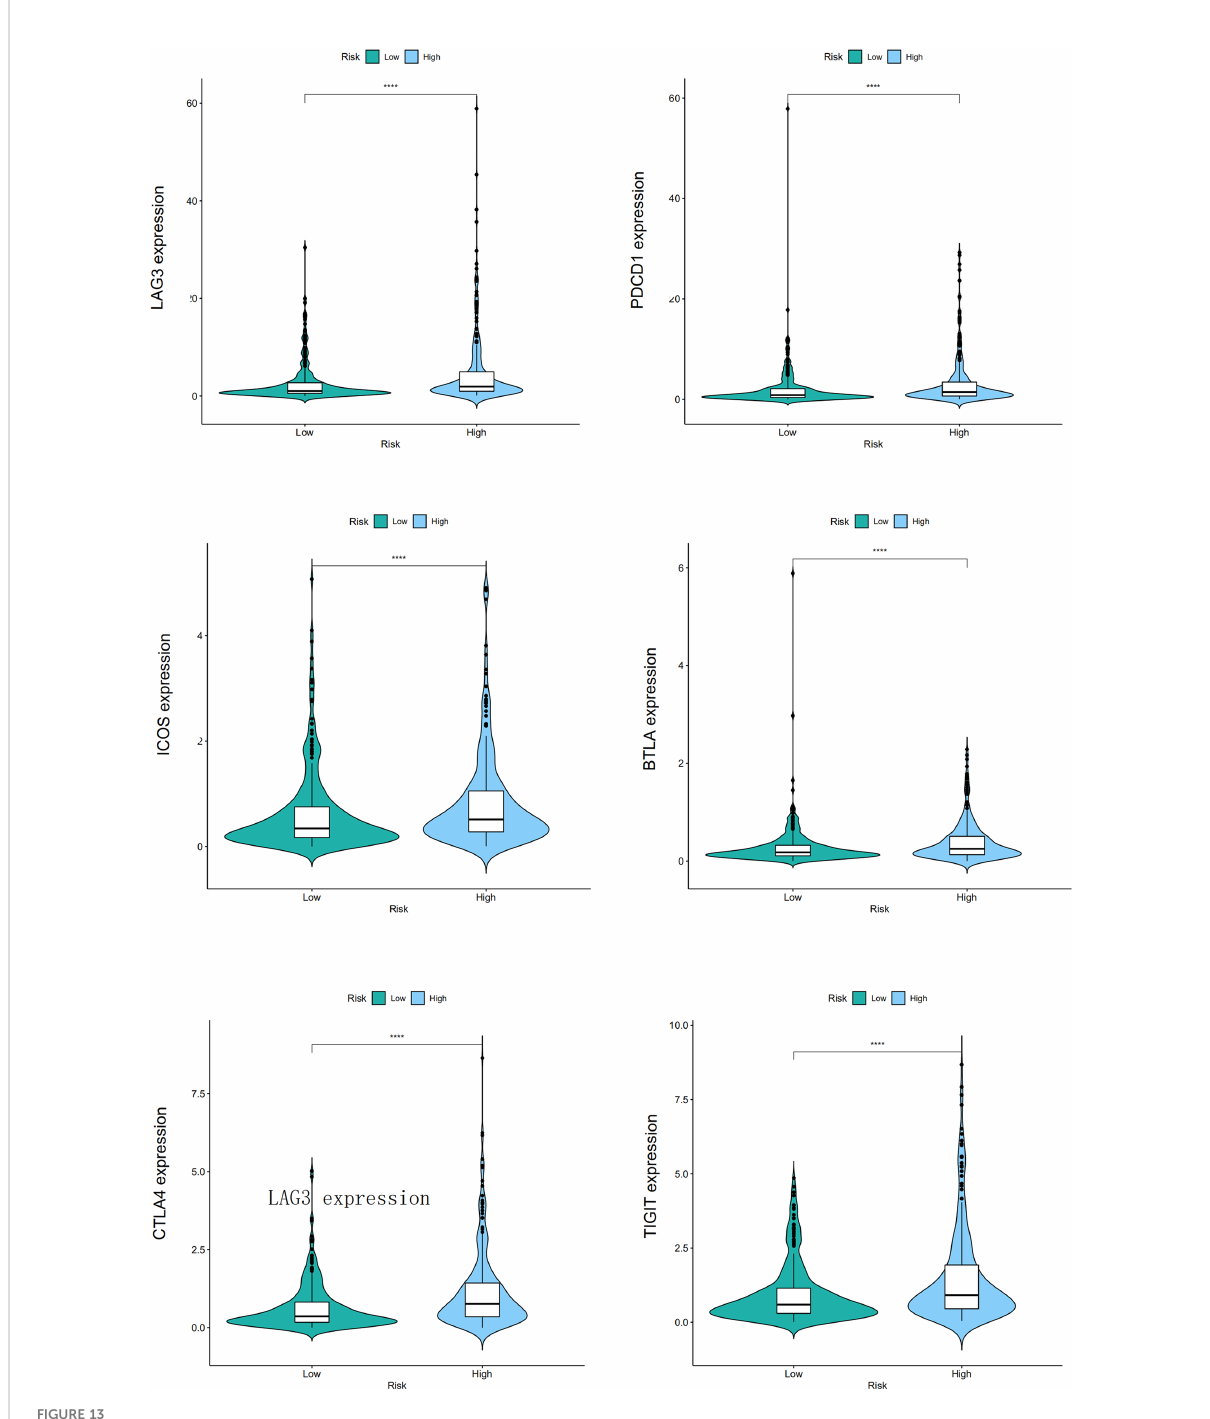
FIGURE 13 The different mRNA levels of immune checkpoint genes between low- and high-risk patients, and the "****" represents P <